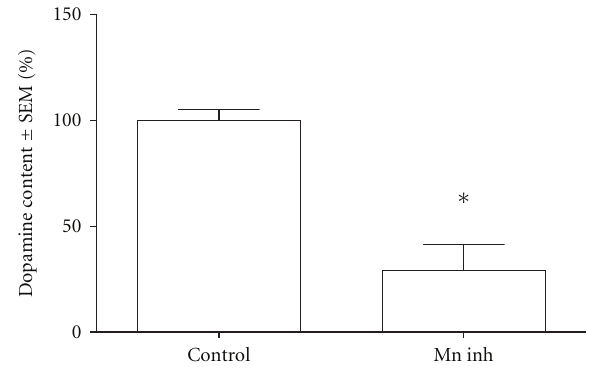
Figure 1: Decrease of dopamine content in the striatum after 5 months of Mn inhalation compared to controls. Contents are expressed as percentages, which were in pg/micro gram of protein ( ∗ P < . 001 versus control group by one-way ANOVA with post-hoc